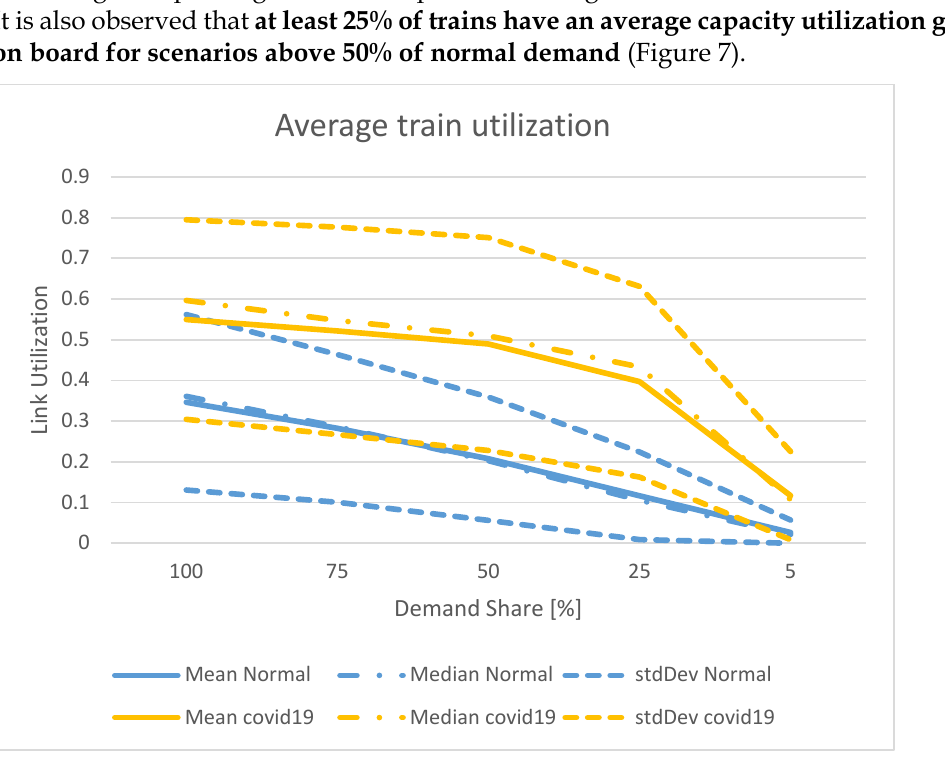
Figure 6. Average train utilization in normal and covid19